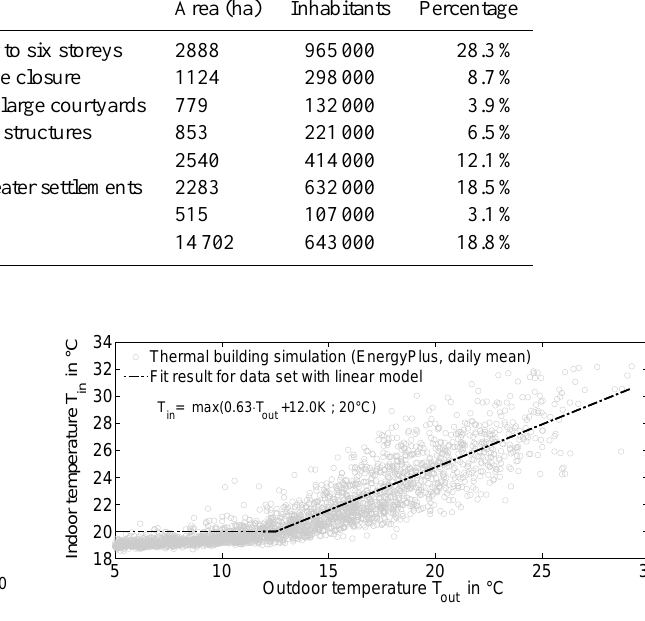
Figure 3. Linear building model (Eq. 10) fitted to mean daily op- erative room temperature of a typical residential building of Berlin simulated with